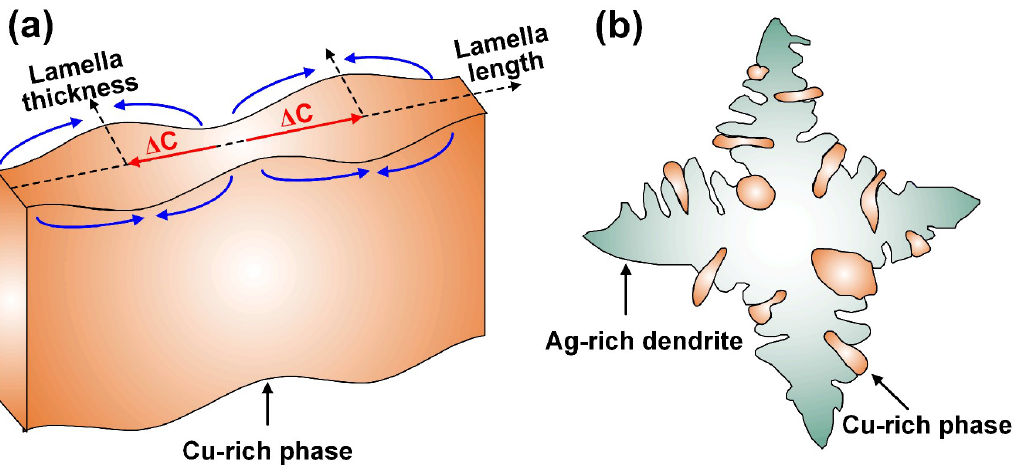
Figure 9. ( a ) Schematic diagram of the AES formation of the Ag-28.1Cu-0.5Sn and Ag-28.1Cu-1Sn alloys and ( b ) schematic diagram of the AES formation of the Ag-28.1Cu-3Sn and Ag-28.1Cu-5Sn alloys.